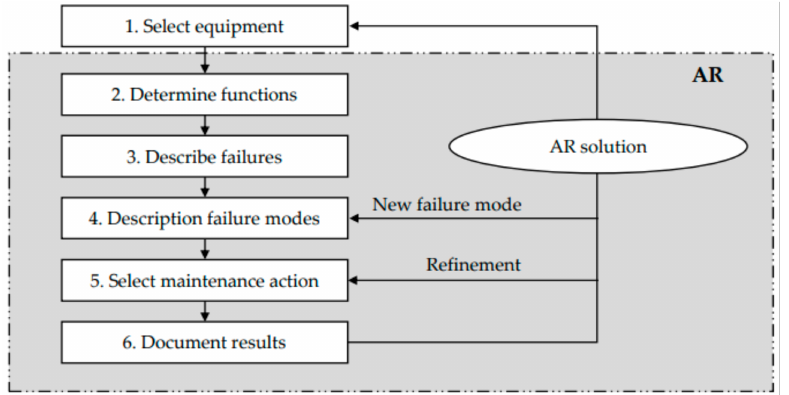
Figure 2. Added value augmented reality (AR) offers maintenance procedures adapted from Camp- bell